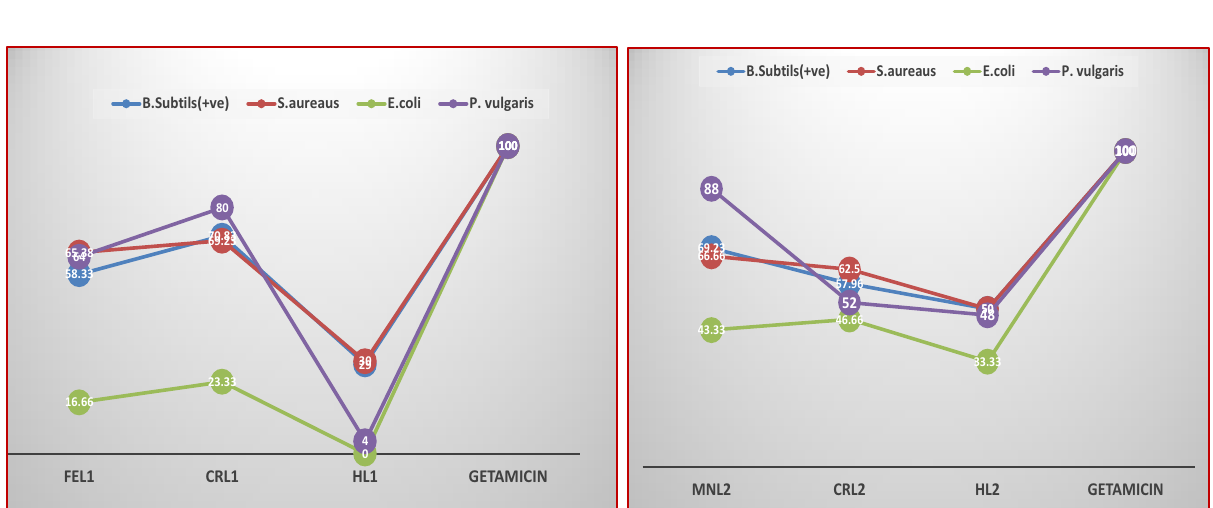
Figure 10. Activity index % values of HL1, HL2 and their metal Cr(III), Fe(III), and Mn(II) ions accounts for the higher antibacterial activity of metal complexes relative to free ligands 26,34 . Compared to the ligand HL1, which has an electron-withdrawing bromo group, the antibacterial activity of ligand HL2 which contains an electron-donating methoxy group in the salicylaldimine moiety has a powerful antibacterial and antifungal effectiveness Fig. 10 and Table S2. The methoxy group of the aldehyde moiety of the Schiff base ligand may help to explain why the vanillin-based ligand HL2 has a greater activity than